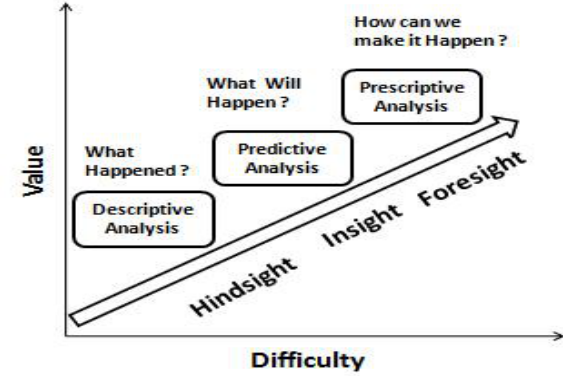
Figure 3. Predictive Analytics value-difficulty